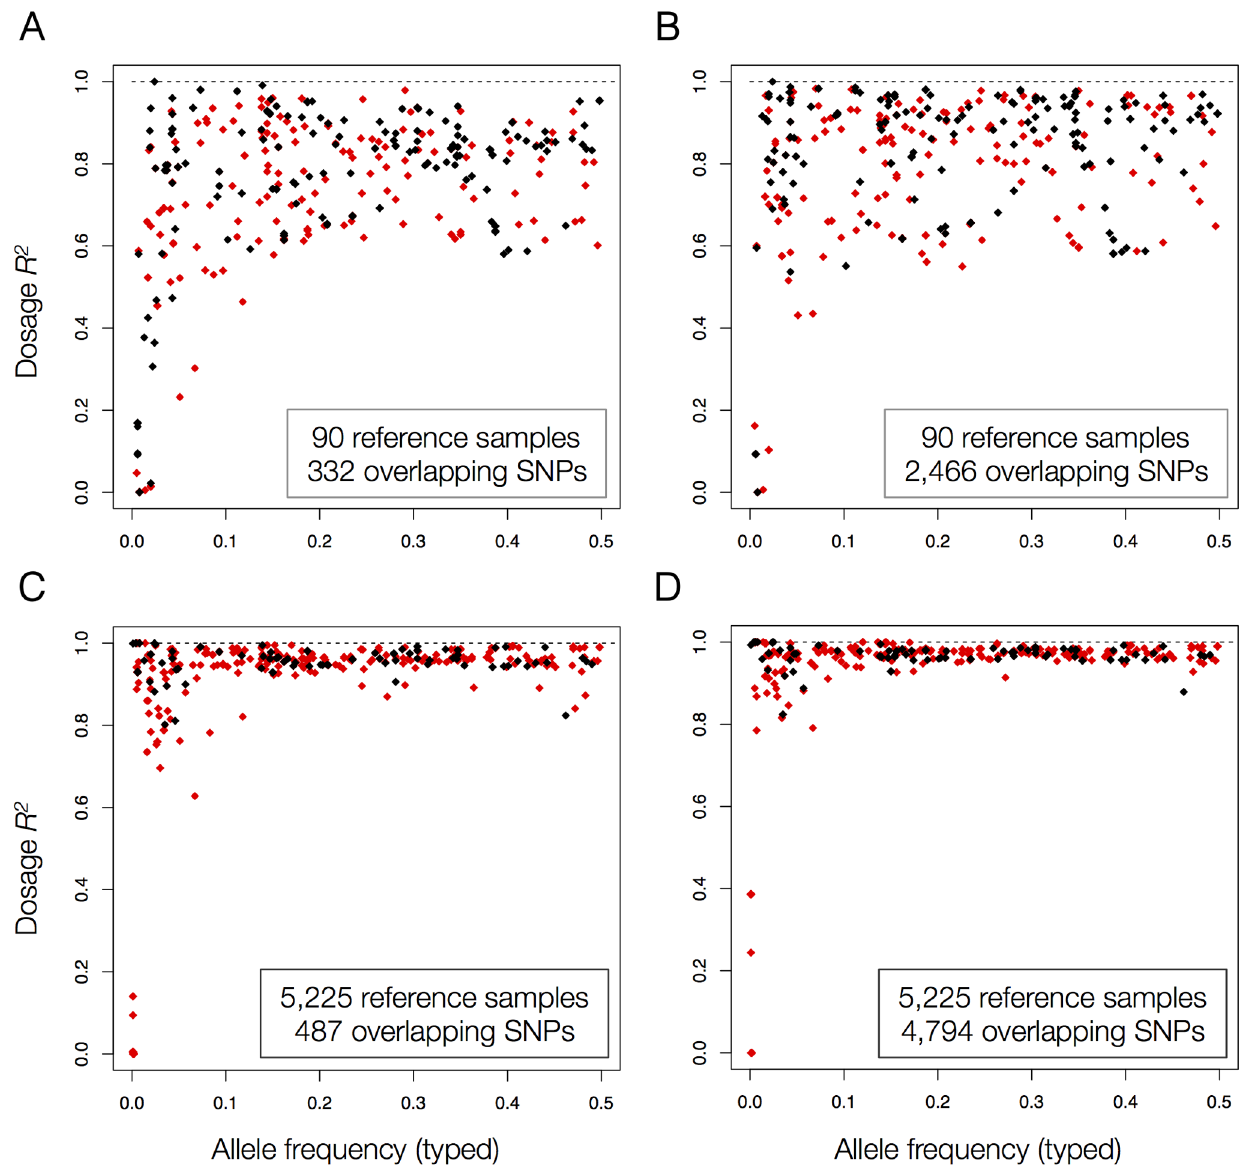
Figure 3. Correlation between imputed and typed dosages ( r 2 dosage ) of polymorphic amino acids in the B58BC as a function of typed allele frequency for imputation from the (a) Affymetrix 500 K or (b) Illumina Immunochip platform using the HapMap-CEPH reference panel, and imputation from the (c) Affymetrix 500 K or (d) Illumina Immunochip platform using the T1DGC reference panel. Black points indicate bi-allelic positions. Red points indicate poly-allelic positions.